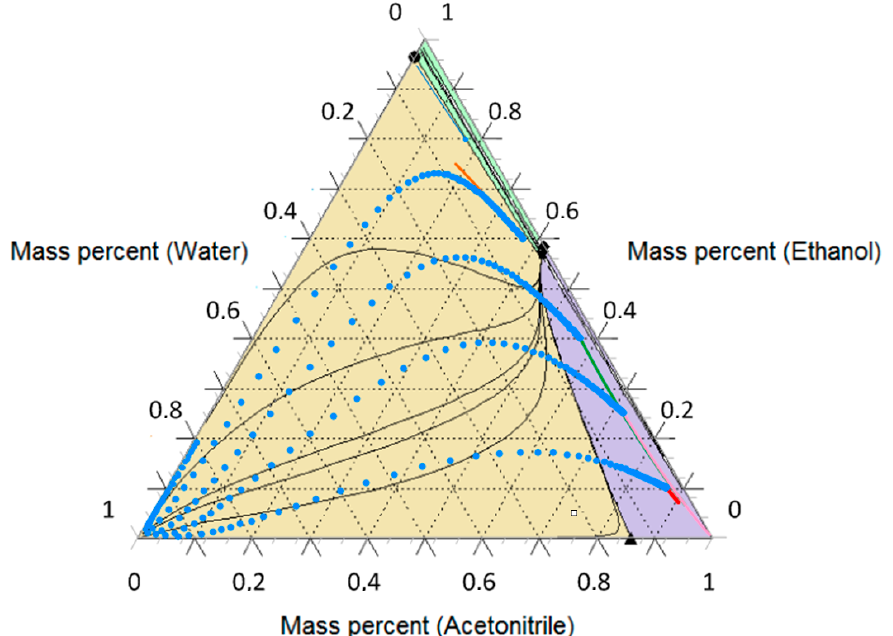
Figure 13. Residual curves for a mixture of ethanol-acetonitrile-water. Lines without AEBA–TEG, dots—when 60 wt.% was added to the initial solution of AEBA–TEG.